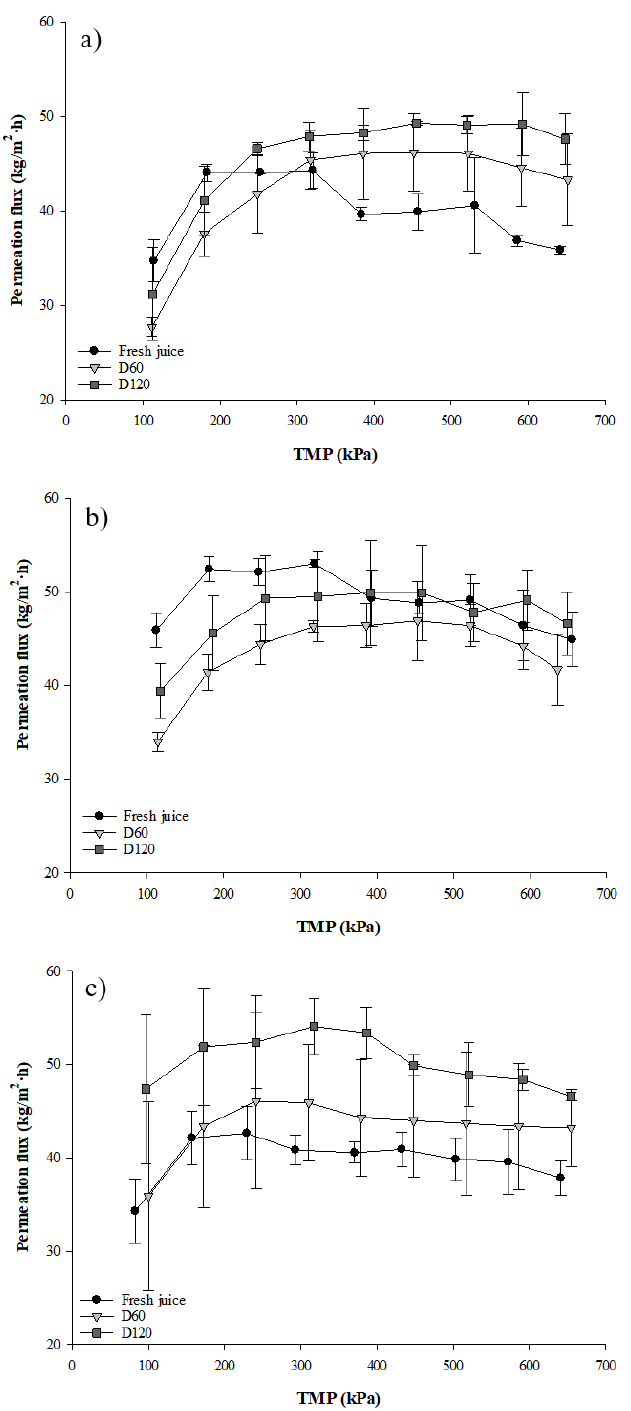
Figure 1. Permeation flux–transmembrane pressure (TMP) relationship for fresh and depectinized (D60 and D120) cranberry juices clarified by ultrafiltration (UF) with membrane MWCO of ( a ) 50 kDa, ( b ) 100 kDa and ( c ) 500 kDa.